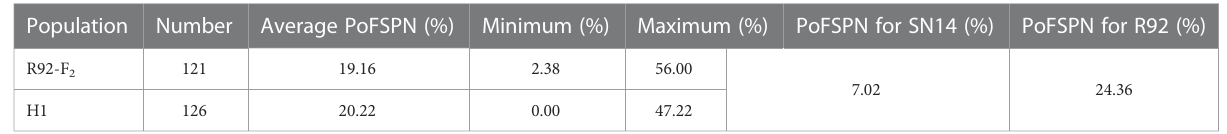
TABLE 2 Phenotypic statistics of PoFSP in the secondary segregated